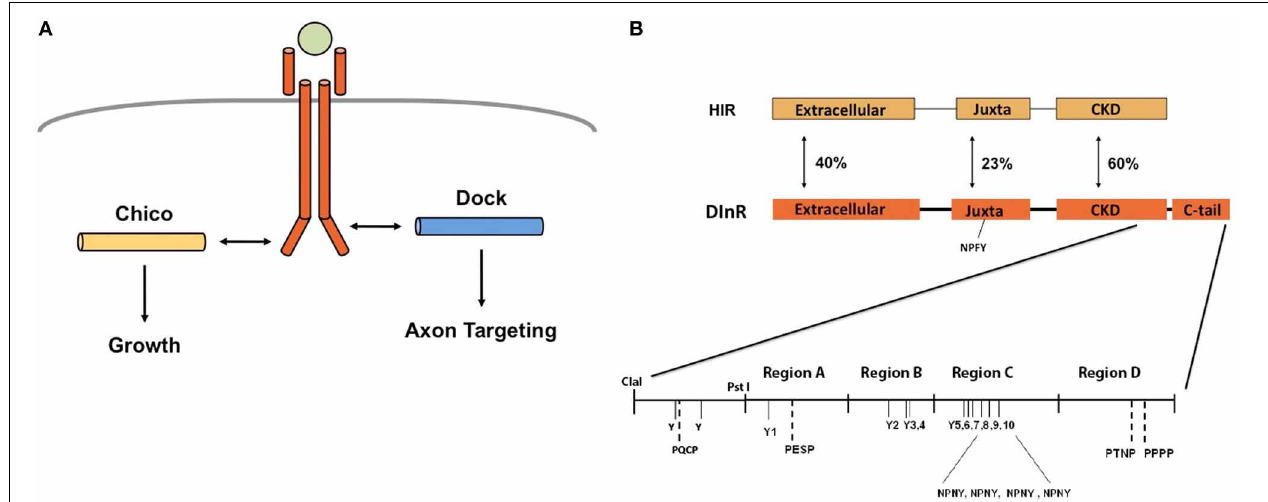
FIGURE 1 | DInR signals independently through Chico and Dock to control growth and axon guidance. (A) We and others proposed that DInR, after DILP binding, signals independently through Chico to control growth and Dock to control axon targeting. Panel modified from Dickson (2003). (B) Schematic of DInR sequence with candidate binding regions indicated. The C-tail of DInR, previously shown to be required for interaction with Dock